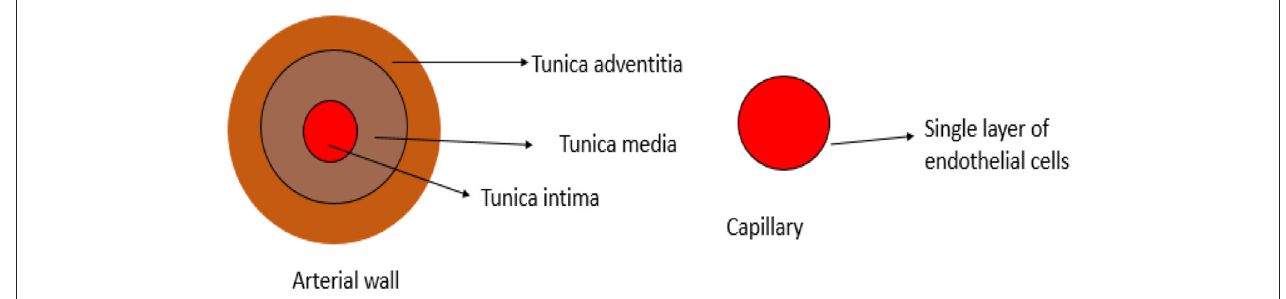
FIGURE 1 | Cross-section of layers in the arterial